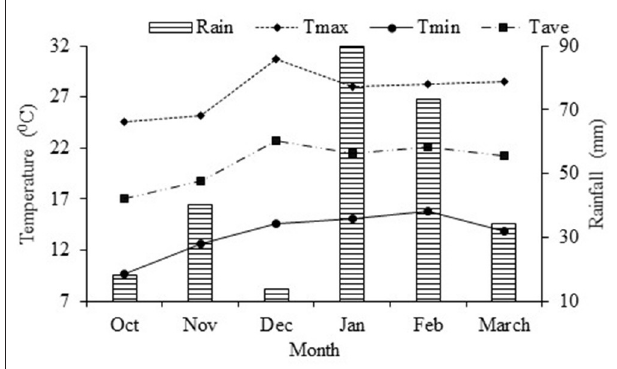
FIGURE 1 | Average monthly rainfall, minimum (Tmin) and maximum (Tmax) temperature readings over the study period of October 2016 to March